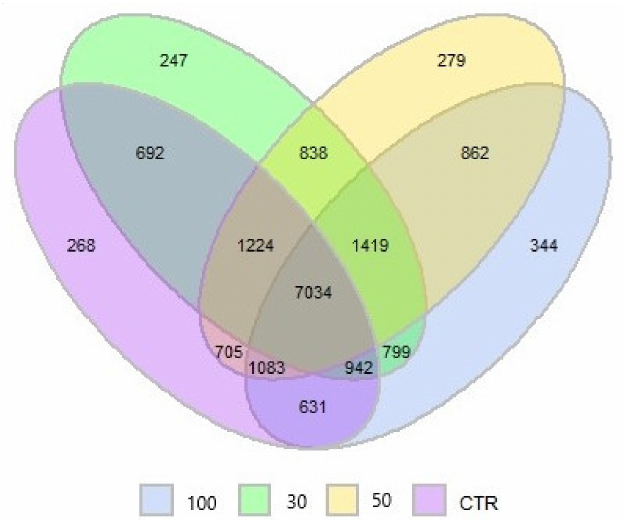
Figure 3. Venn diagram showing Operational taxonomic unit shared between the four treatments (CTR: control ( n = 8); 30: 30 g / kg spent co ff ee grounds ( n = 9); 50: 50 g / kg spent co ff ee grounds ( n = 9); 100: 100 g / kg spent co ff ee grounds ( n =